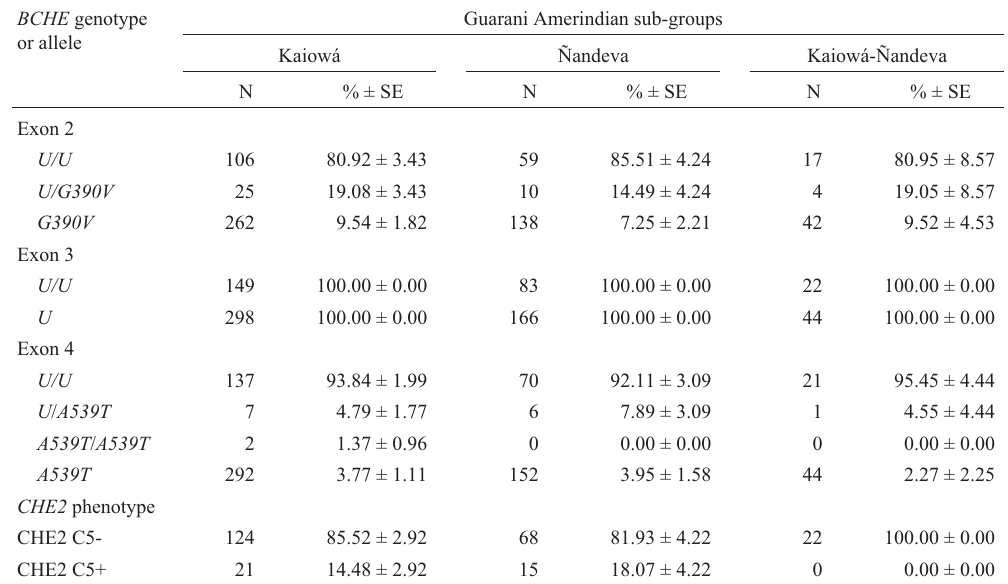
N = number of individuals for genotypes and phenotypes and number of genes for alleles.